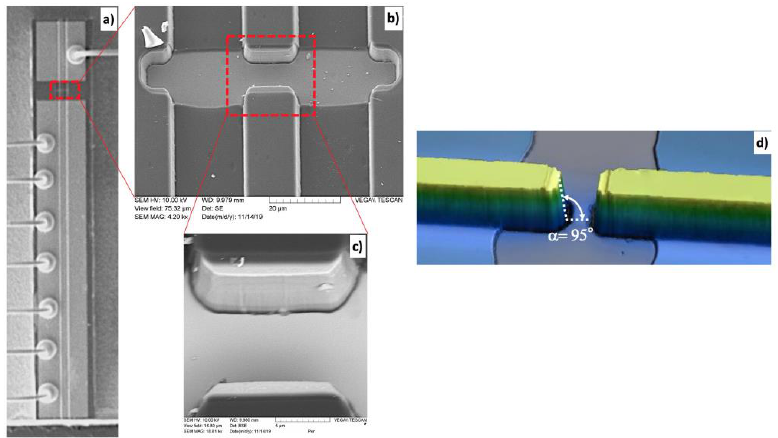
Figure 3. SEM images of dry-etched fabricated CC-QCL with close up on dry-etched optical gap. The whole device ( a ), close-up on the dry-etched optical gap ( b , c ). Laser scanning confocal